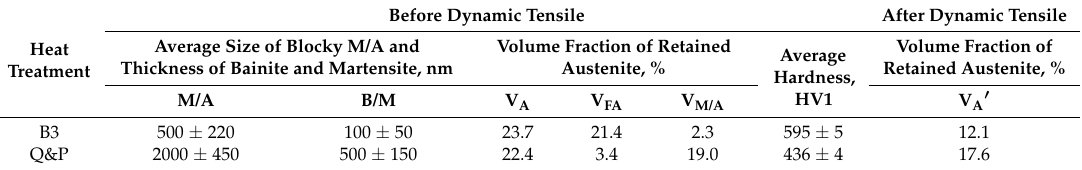
Table 2. The measured average size of blocky martensite/austenite (M/A) and thickness of bainite and martensite, hardness and the volume fraction of retained austenite before and after dynamic tensile testing under the strain rate of 500 s − 1 for different heat treatments.